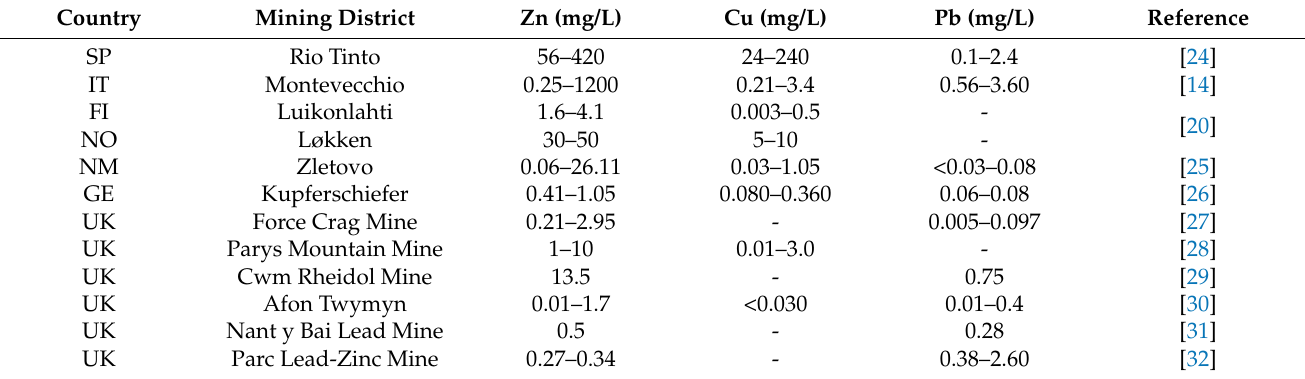
Table 1. Zn, Cu and Pb average concentration ranges in some water impacted by non-coal mines in Europe.